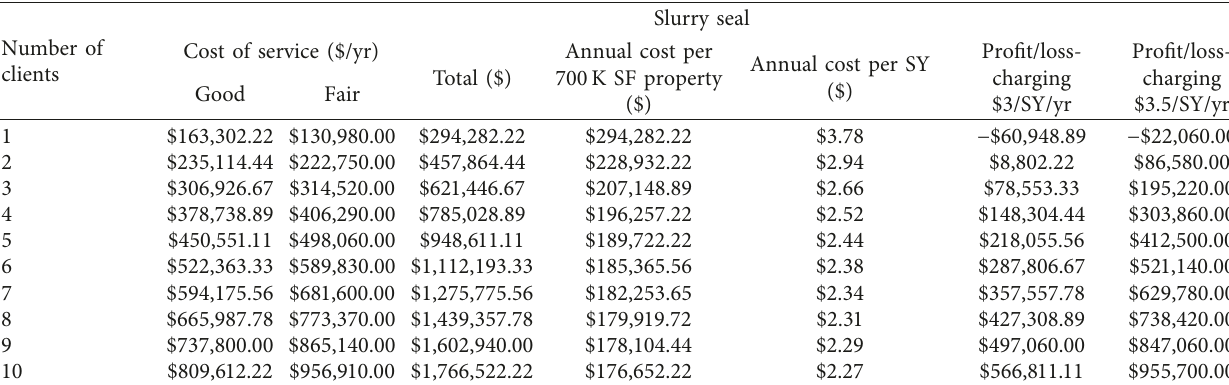
Table 7: Annual profit/loss per SY using slurry seal treatment.